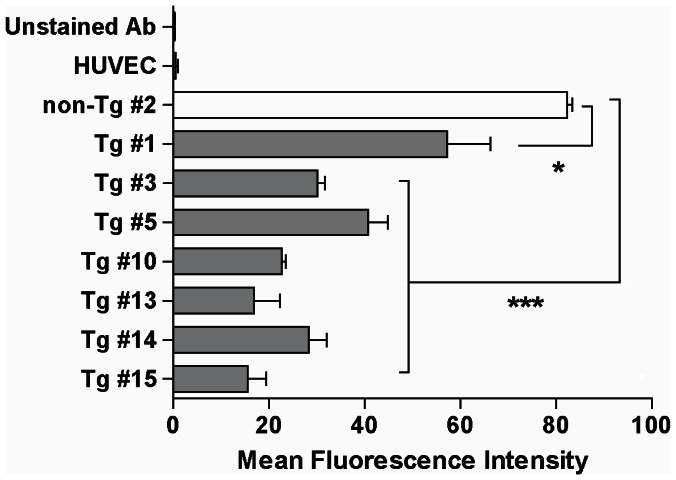
The expression of the α-Gal epitope in SUVECs by flow cytometry analysis.The bar graphs represents the average mean fluorescence intensity of Gal α-1,3-Gal antigen in Tg SUVECs (n = 7) compared with non-Tg SUVECs (n = 1) and HUVECs (n = 1). SUVECs were stained with GS-IB4 lectin, which binds to the Gal α-1,3-Gal antigen. The stained cells were analyzed with a FACS. The binding of GS-IB4 was decreased by 29.5% in Tg SUVECs compared with non-Tg SUVEC (P<0.0001). HUVEC was negative for GS-IB4 lectin staining. Data are expressed as the mean ± SDS in three independent experiments.